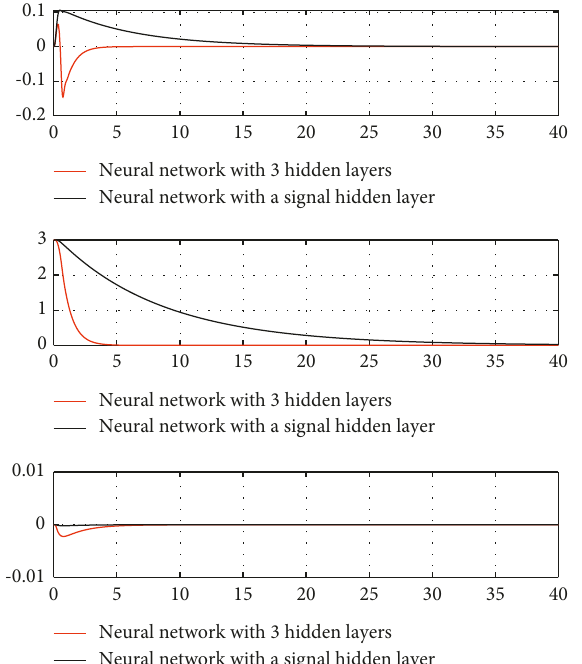
Figure 7: The tracking error with different hidden layers neural network.